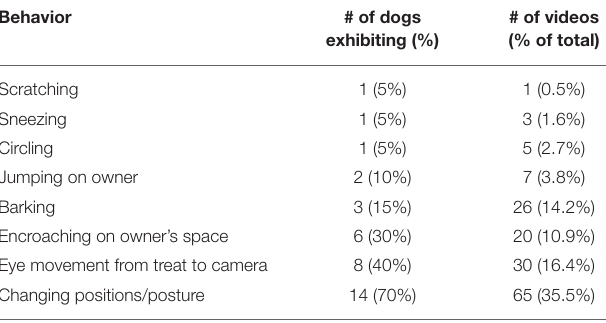
TABLE 2 | Summary of behaviors that occurred during the sustained gaze